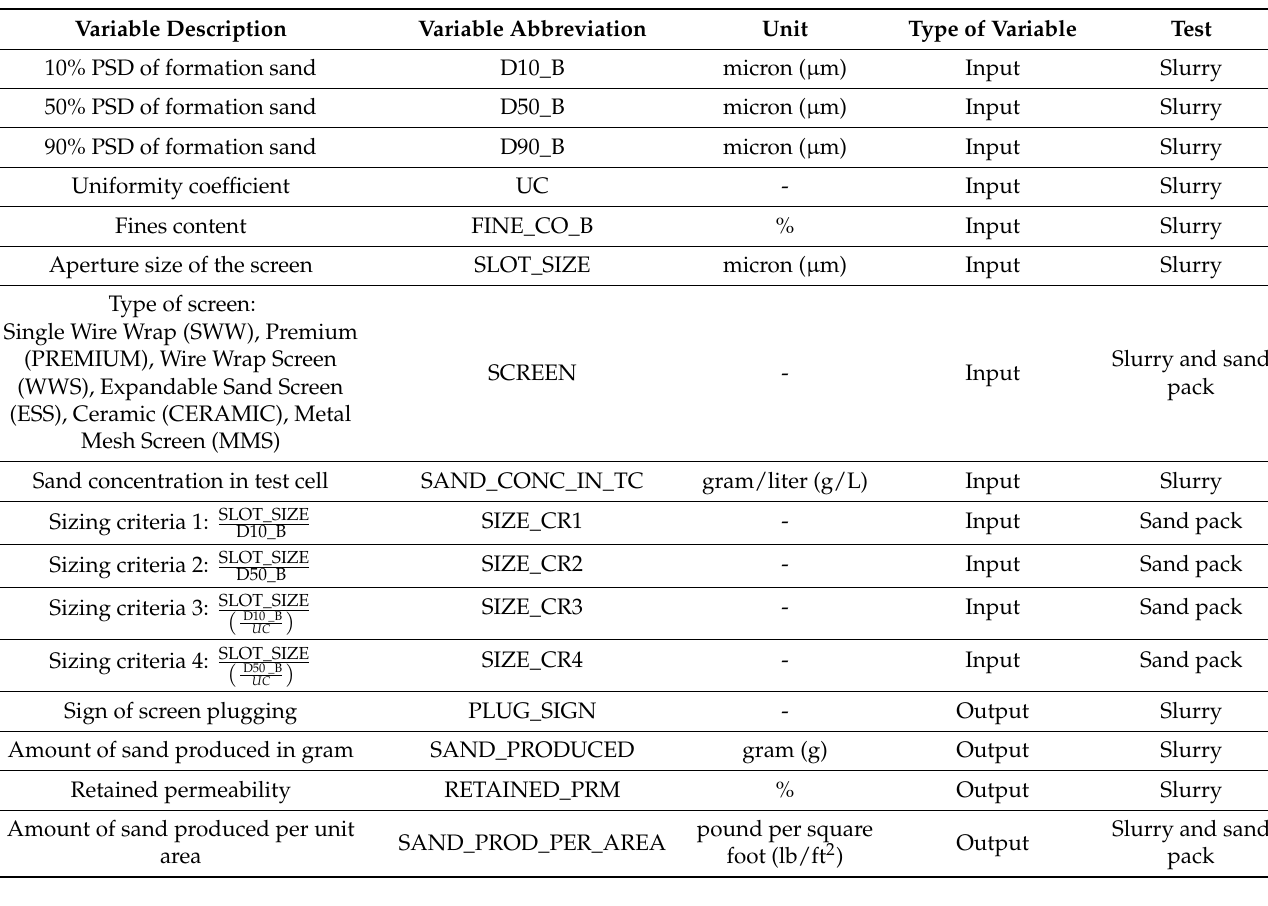
Table 1. The reduced set of variables.